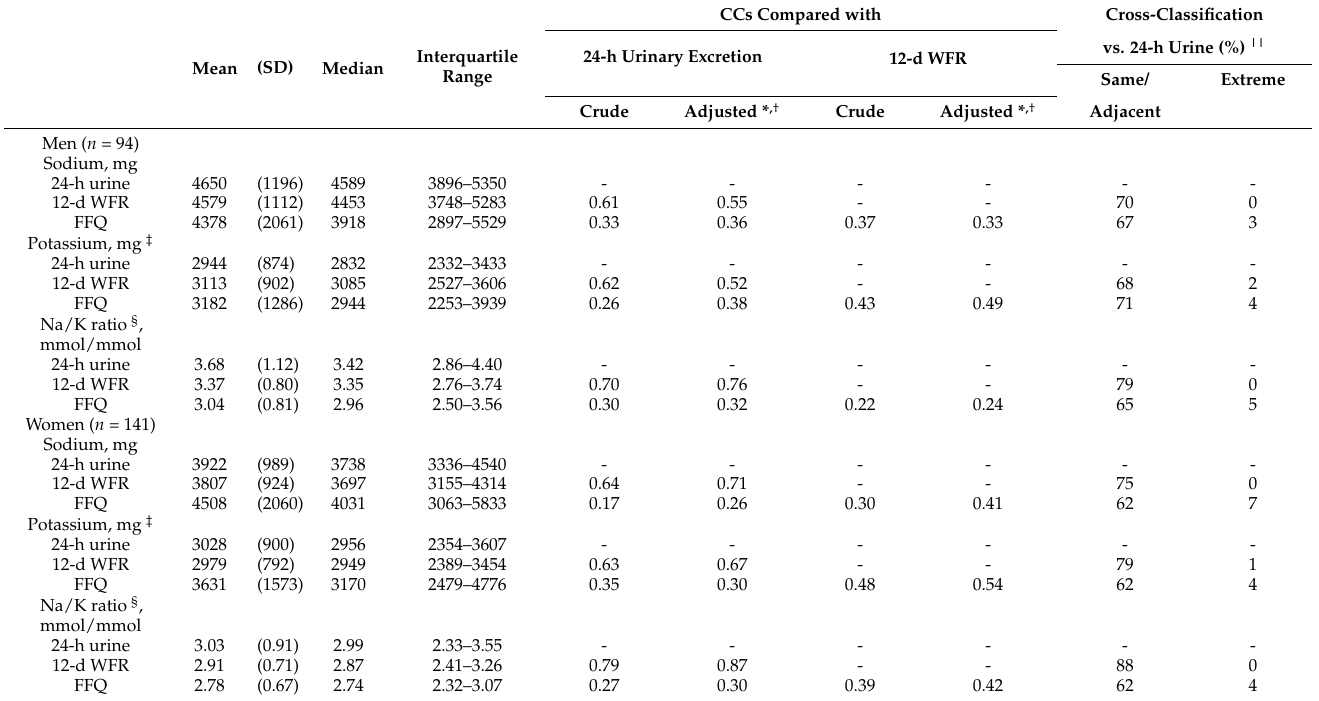
Table 2. Comparison of sodium and potassium intake levels based on multiple 24-h urinary excretion measurements, FFQ, and 12-d WFR, as well as their